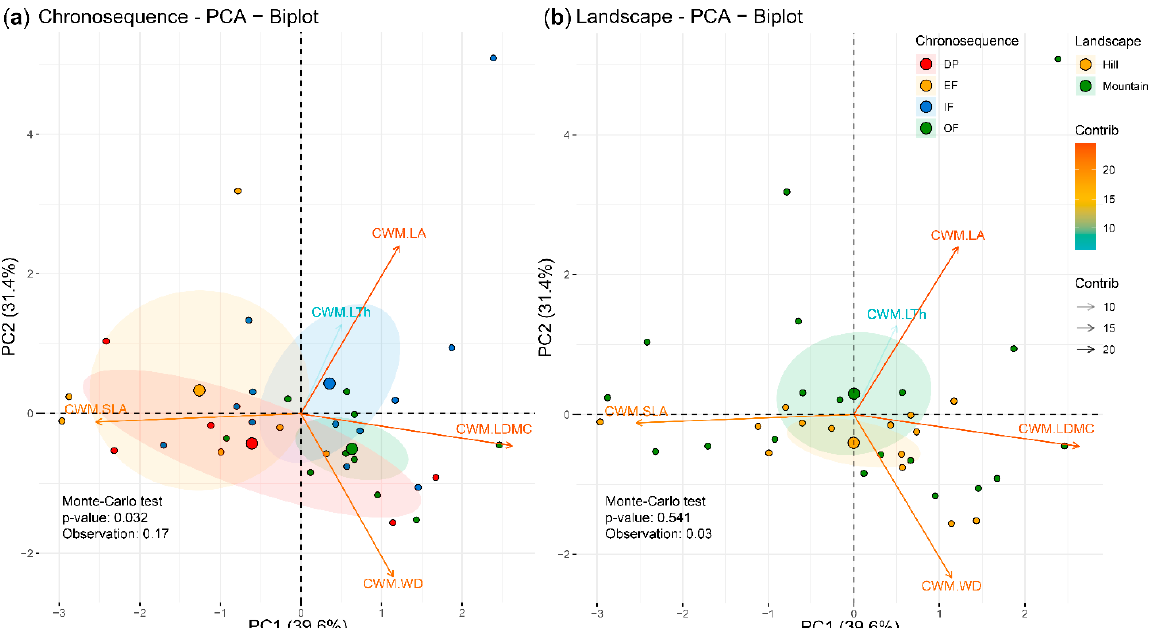
Figure 2. Principal component analysis (PCA) with the community-weighted means (CWMs) of plant traits and the sampling plots projected on the ordination plane PC1/PC2. The color of the vectors indicates the contribution of the variables to the PCs; 95% confidence ellipses. ( a , b ) Sampling plots grouped by chronosequence (DP, degraded pasture; EF, early forest; IF, intermediate forest; OF, old-growth forest or mature forest) and landscape (hill and mountain), respectively.